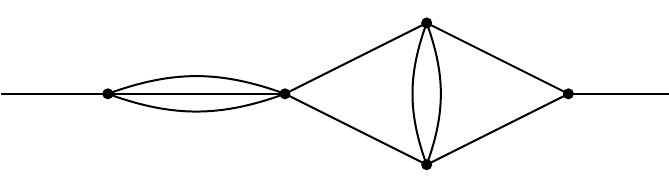
Figure 8 . This five-loop master integral is a product of two-and three-loop master integrals. The knowledge of its expansion, together with the recursively one-loop integrals, is sufficient to determine the expansions of all remaining master